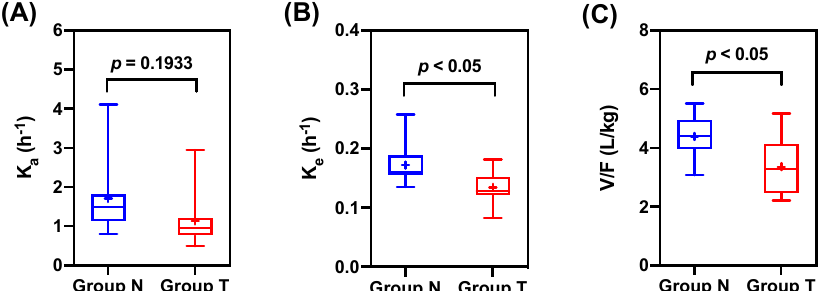
Figure 4. Comparisons of the one-compartment model parameters of tadalafil in non-pretreated rats (Group N) and ticagrelor-pretreated rats (Group T). Boxes mean 25th and 75th percentiles of data and whiskers mean 5th and 95th percentiles of data. The median and mean values are displayed as a solid line (–) and a plus mark (+) in boxes, respectively. ( A ) K a ; ( B ) K e ; ( C ) V/F. Absorption rate constant from the gut compartment to the central compartment (K a ); elimination rate constant from the central compartment to the gut compartment (K e ); the central volume of distribution (V/F).